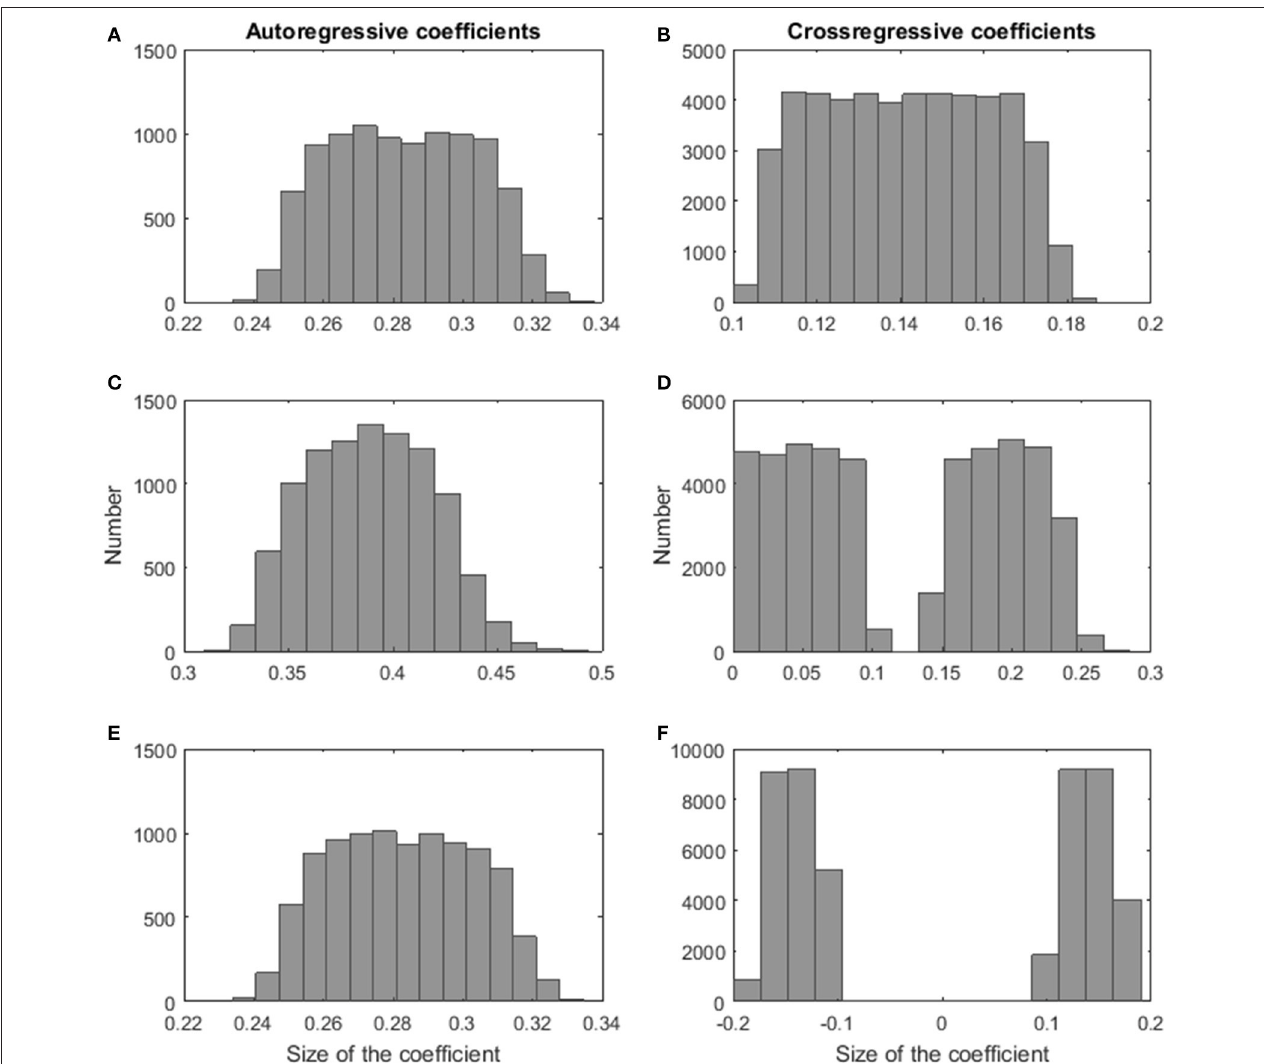
FIGURE 1 | Histograms of the size of the VAR(1) coefficients of the simulation study. The autoregressive and the cross-regressive coefficients of the highly similar clusters condition (respectively A , B ), the autoregressive and the cross-regressive coefficients of the similar clusters condition (respectively C , D ), and the autoregressive and the cross-regressive coefficients of the highly dissimilar clusters condition (respectively E , F